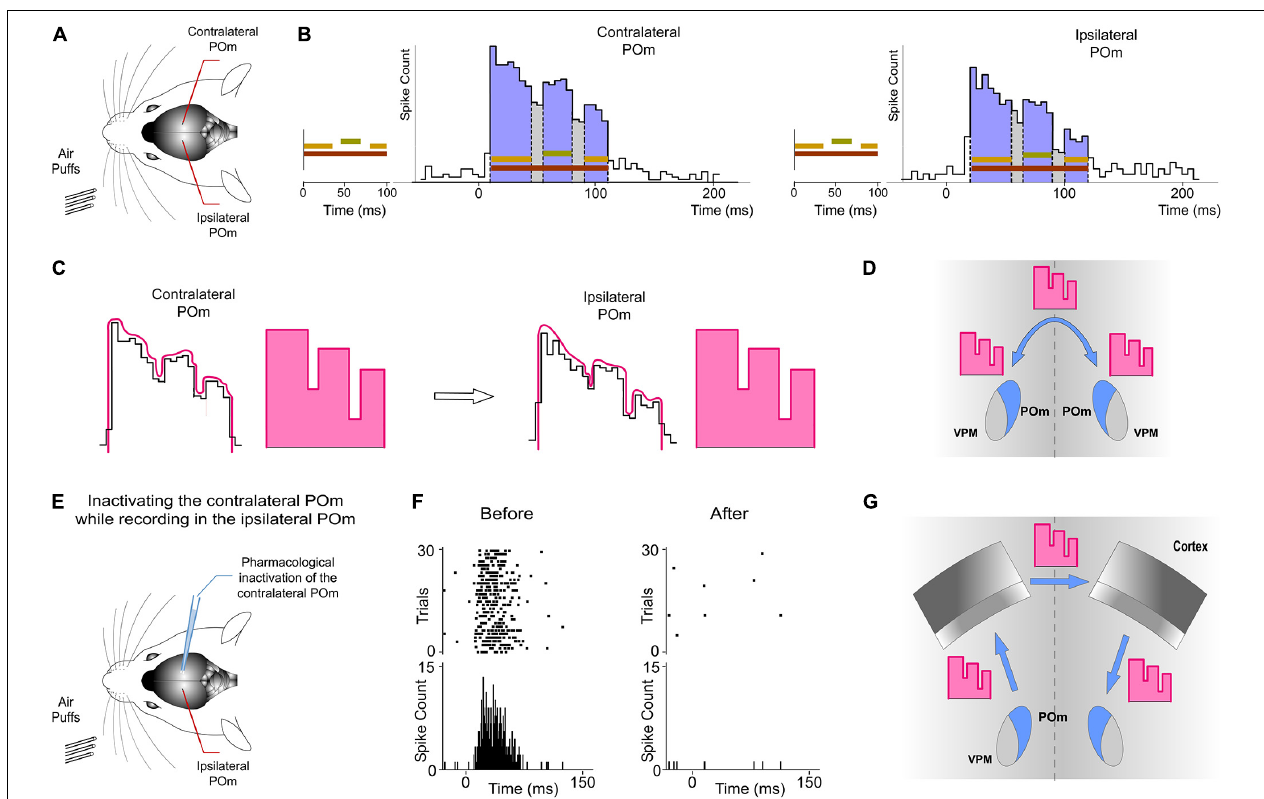
FIGURE 10 | Ipsilateral sensory information is received by one POm from the other POm. This activity was transmitted preserving its integrated structure across the POm-POm loop. (A) Unilateral overlapping sensory patterns were applied while extracellular recordings were performed in both POm nuclei simultaneously. (B) POm responses evoked by these patterns showed different onset latencies but similar integrated structure in the contra- and ipsilateral POm nuclei. As can be appreciated in these representative PSTHs (bin width 5 ms) of POm responses, precise changes in POm activity caused by the integration of overlapping signals were similar in the contra- and ipsilateral POm nuclei. Note that the onset latency was longer in the ipsilateral POm. (C) PSTHs in B show that precise changes (fluctuations represented by lines in pink) in POm sustained activity caused by the integration of overlapping stimuli were precisely conserved. Therefore, these “structured patterns” of integrated information encoded by POm (represented by schematic patterns in pink) were interhemispherically transmitted to the other POm preserving their integrated structure (D) . (E) POm responses to ipsilateral stimulation were studied before and after pharmacological deactivation by muscimol (1 mg/ml) injection in the opposite POm. (F) POm responses to ipsilateral stimulation were abolished when the opposite POm was pharmacologically deactivated. (G) The latencies suggest that the POm-POm loop could be formed by a thalamocortical-callosal-corticothalamic